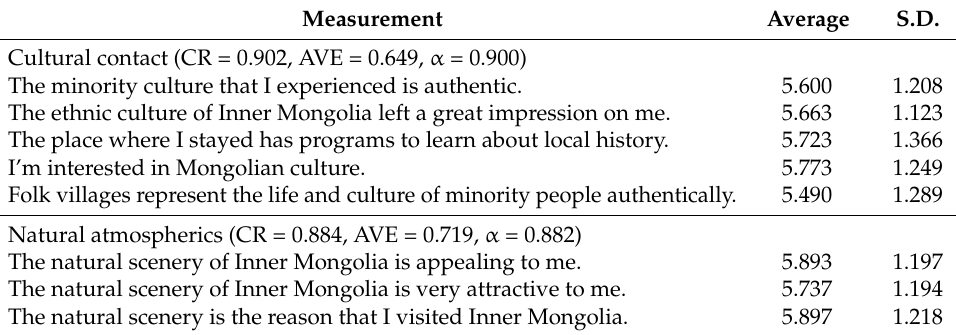
Table 1. Measurement model assessment.